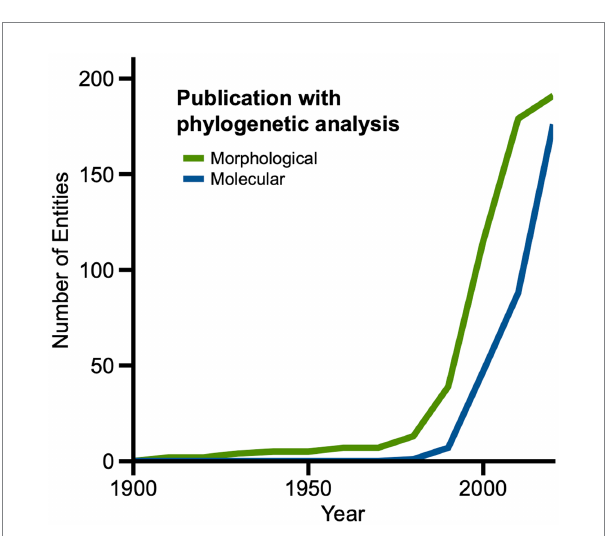
FIGURE 10 Line graph showing changes in numbers of living fossil entities from 1860 to 2020 designated in publications that incorporate morphological or molecular phylogenetic analyses.